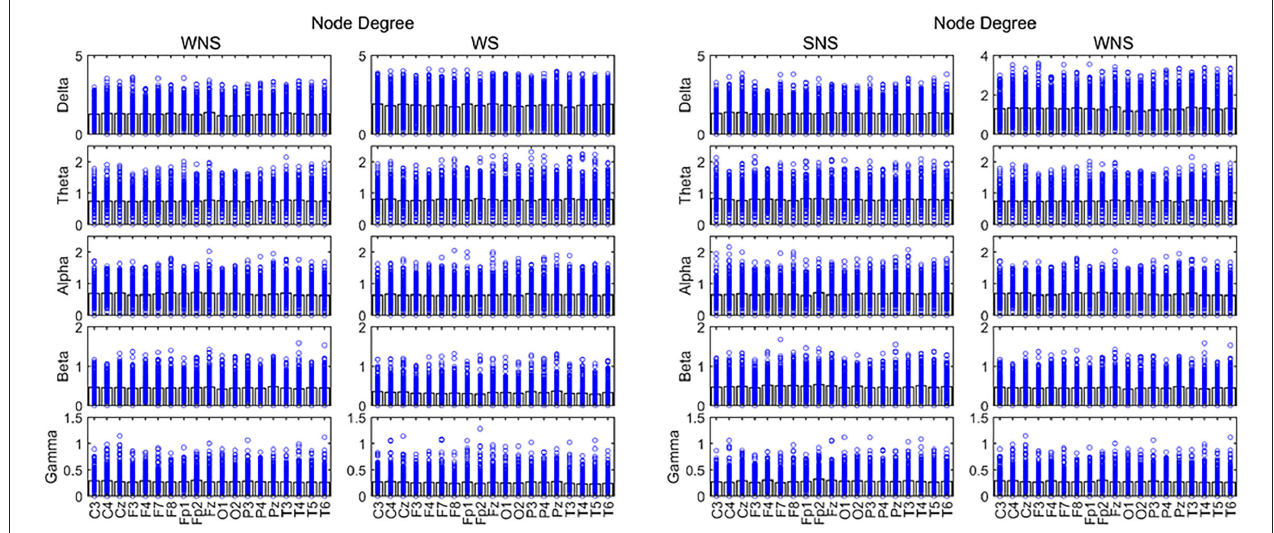
FIGURE 3 | Node degree (ND) in different frequency bands. Two-sided non-parametric Wilcoxon rank-sum tests were taken. Connectivity capabilities of slow waves in the forehead increased in the ictal phase ( P < 0.05). The alpha band was stronger, while slow waves and the beta band were weaker in local EEG connectivity ( P <